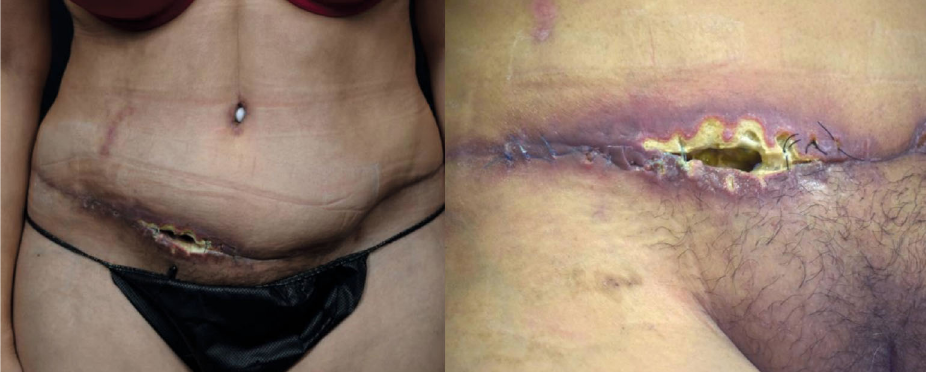
Figure 1: The patient ’ s ventral view with initial dehiscence and fl ap necrosis.